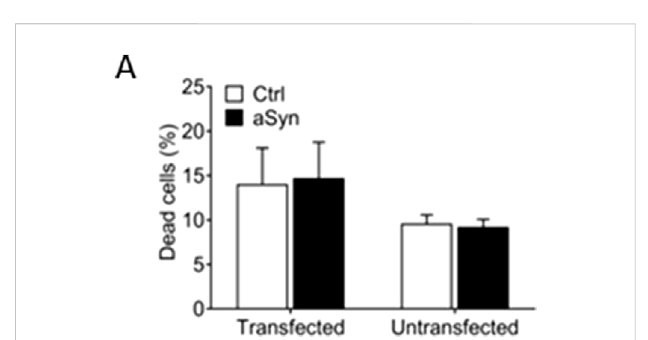
FIGURE 7 OverexpressionofaSyn hasno effecton cellviability. (A) INS-1cells were transfected with an aSyn-VENUS vector or control VENUS vector for 48 h before being analyzed. There was no difference in dead cell proportions between the aSyn-VENUS transfected group and the control group. Student ’ s t-test, mean ± SD., n =